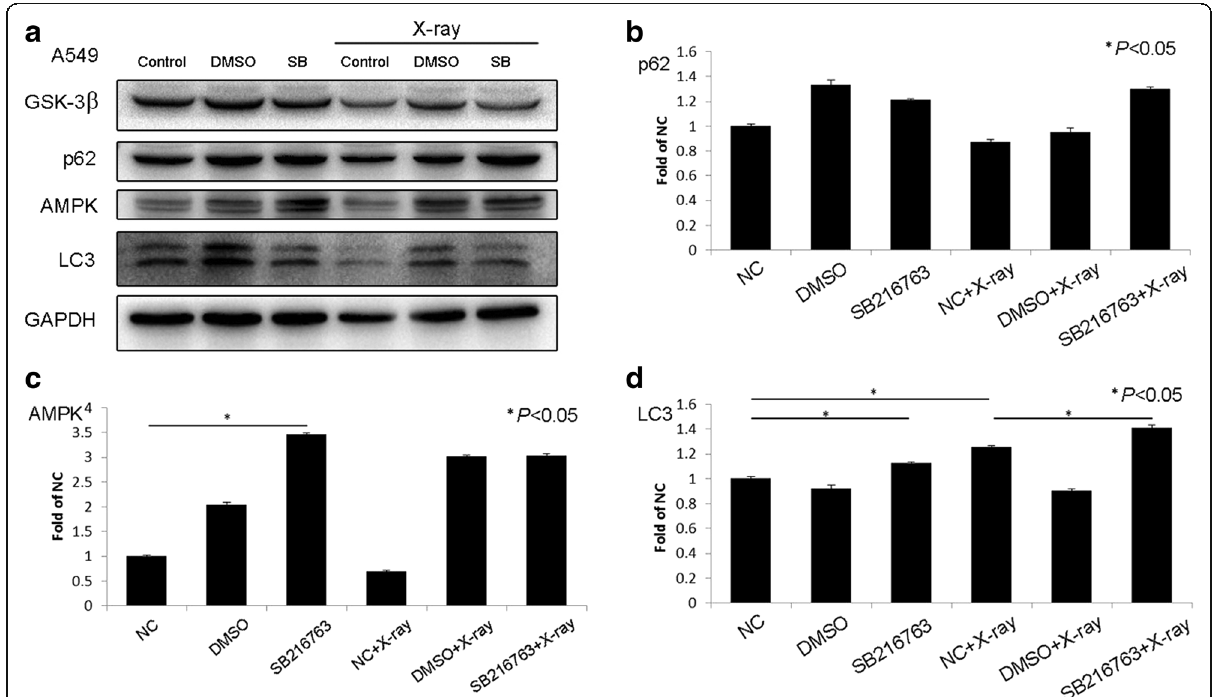
Fig. 5 GSK-3 β inhibition promoted cellular autophagy. Western blotting showed that ( a ) after X-ray irradiation alone, GSK-3 β levels decreased; p62 and AMPK levels did not change significantly; and LC3 levels increased in A549 cells. After treatment with the GSK-3 inhibitor SB216763, p62 levels did not change significantly, whereas AMPK and LC3 levels increased. After treatment with the GSK-3 β inhibitor SB216763 and X-ray irradiation, p62 and AMPK levels did not change significantly, whereas LC3 levels increased ( b , c , d ). * P <